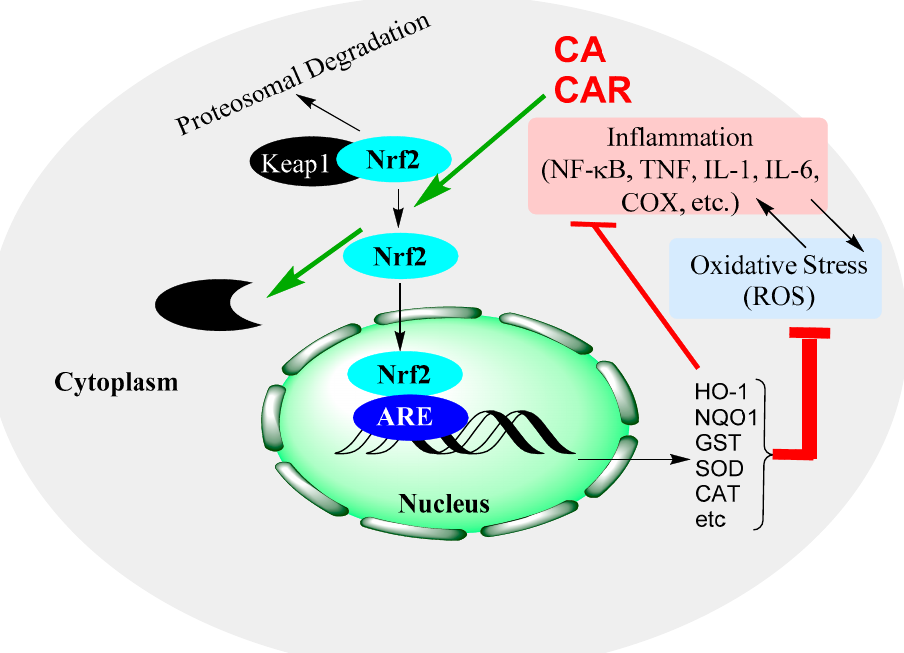
Figure 5. Induction of the Nrf2 signalling pathway and modulation by CA and CAR. Nrf2 activation leads to the expression of antioxidant genes, which, in turn, increase the levels of antioxidant proteins that resolve oxidative stress in cells. The pathway also inhibits inflammatory genes’ activation and has indirect impacts by removing the oxidative stress component of inflammation, oxidative stress crosstalk.